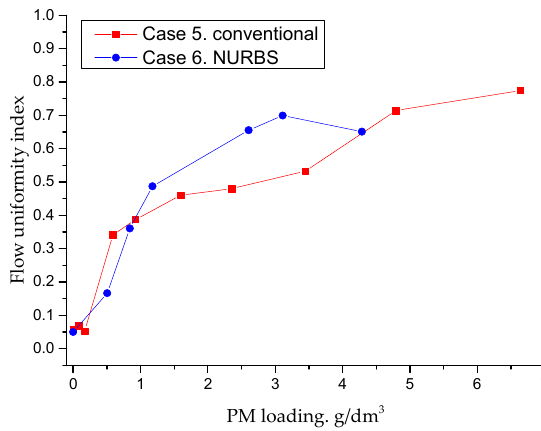
Figure 14. Comparison of flow uniformity index.